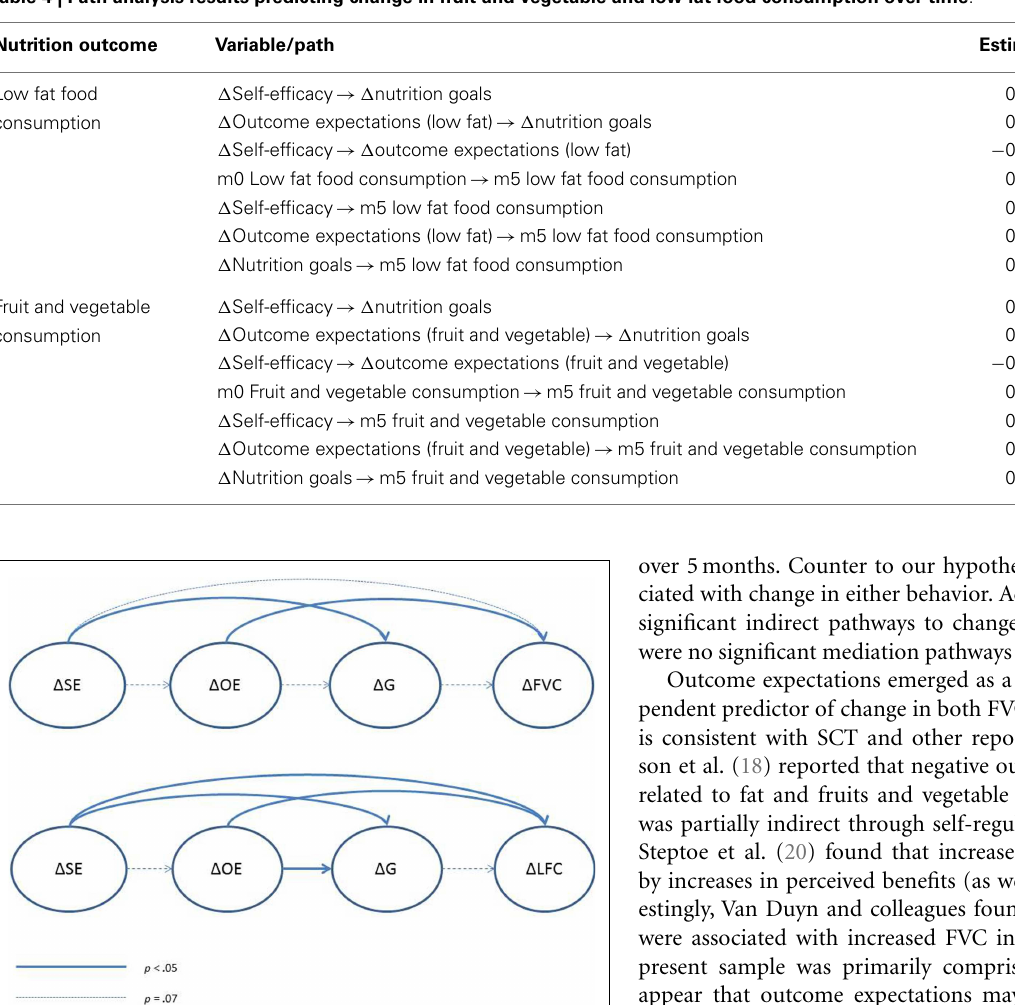
Table 4 | Path analysis results predicting change in fruit and vegetable and low fat food consumption over time .